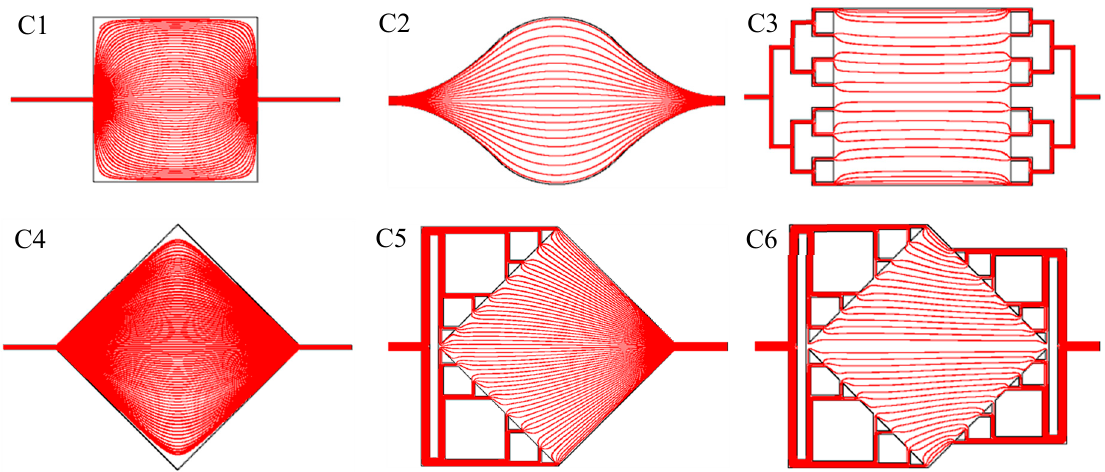
Figure 3. Numerical simulation of flow lines in the microfluidic interfaces of Figure 2.